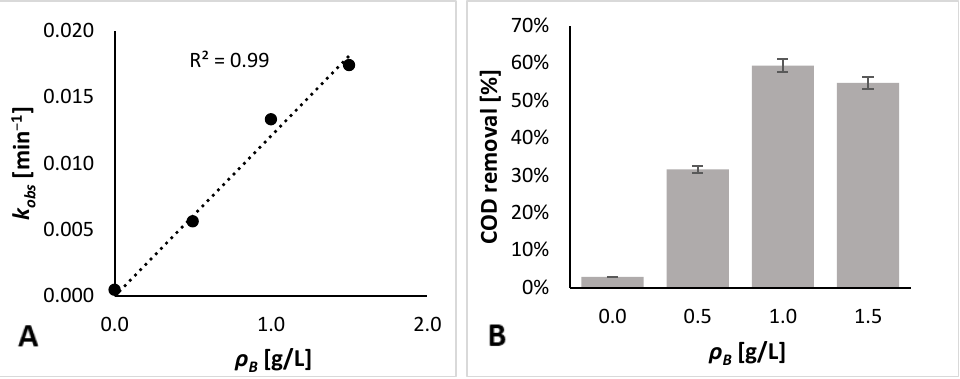
Figure 5. Effect of the catalyst loading on ( A ) the observed reaction rate, r obs , and ( B ) the COD plateau value, COD F .